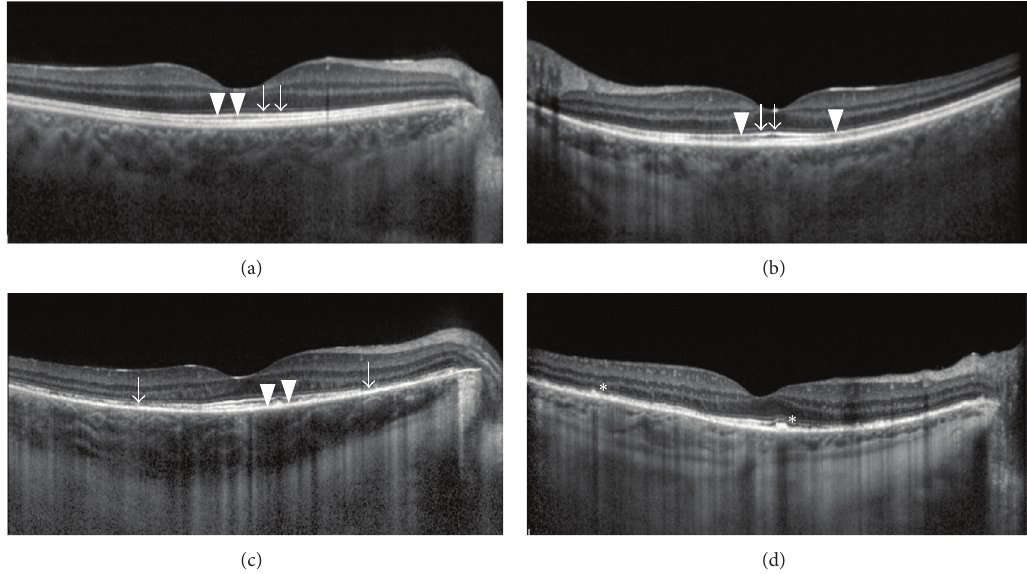
Figure 1: Standards for OCT grading: (a) intact COST line (arrowheads) and junction between the photoreceptor inner and outer segments (IS/OS) line (arrows) with normal RPE layer; (b) discontinuous COST lines (arrowheads) and intact IS/OS line (arrows); (c) discontinuous COST line (arrowheads) and IS/OS line (arrows); and (d) thickened RPE layer